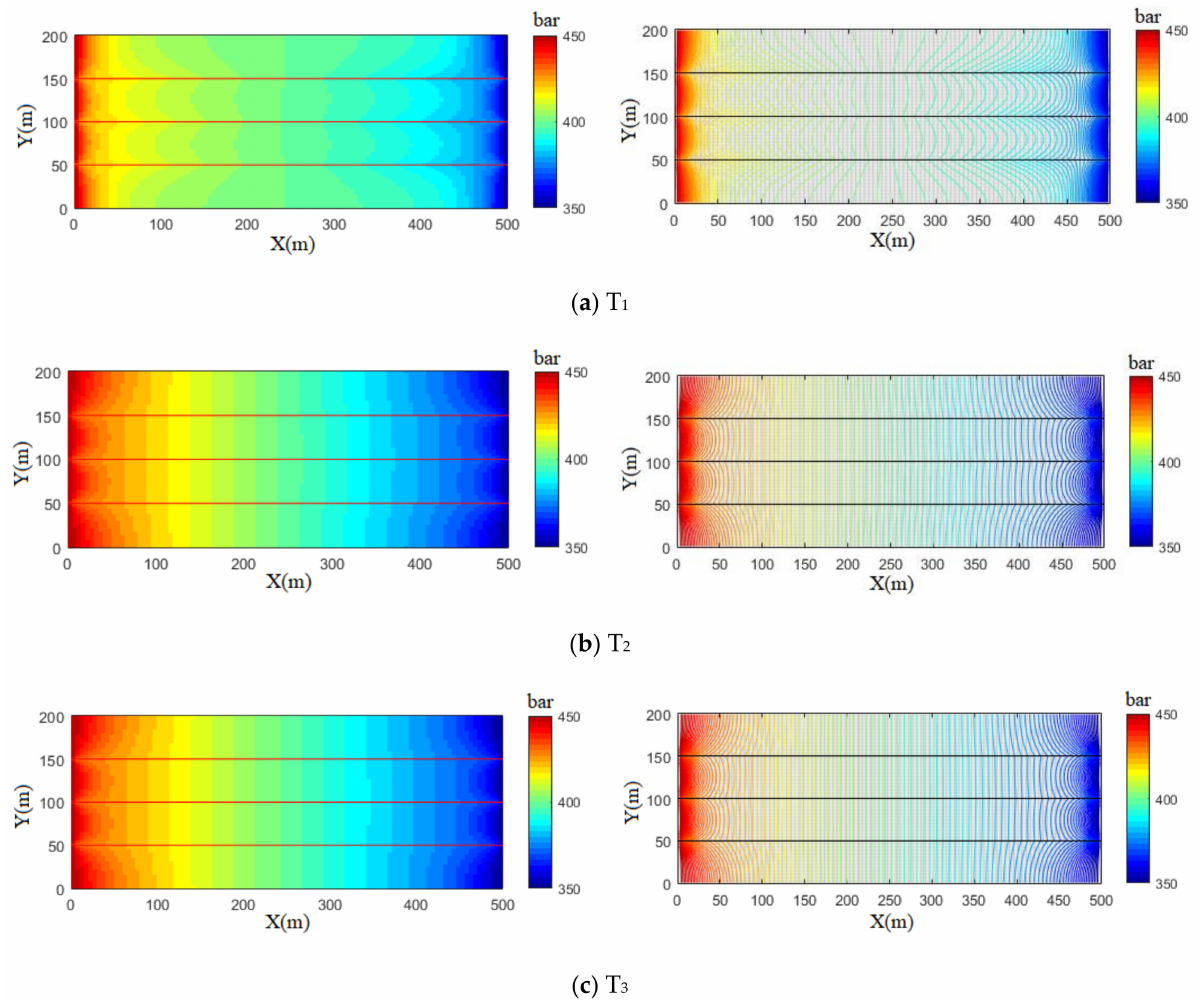
Figure 2. The pressure distribution marked by color (pictures on the left side) and contour (pictures on the right side) at different times (T 3 > T 2 > T 1 ). Compared with ( a – c ), water flows preferentially in fractures and a high-pressure drawdown occurs in fractures at first. The contour is curved. With the time advancing, the pressure in matrix starts to drop and the contour becomes more parallel in the later